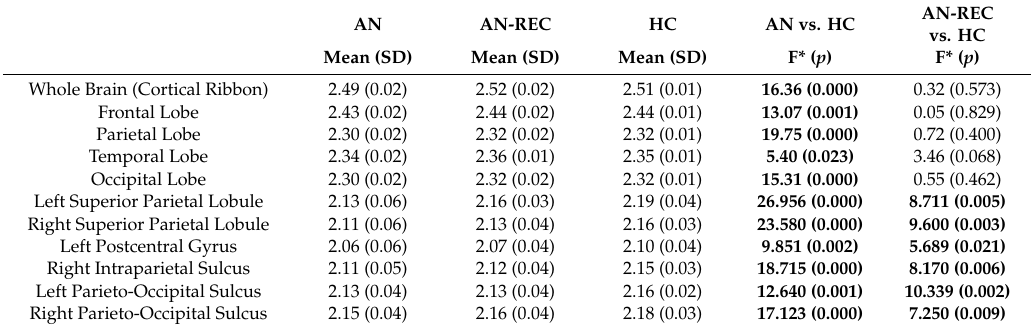
Table 2. Cortical structures FD di ff erences analysis between AN, REC-AN, and HC groups. AN AN-REC HC AN vs. HC